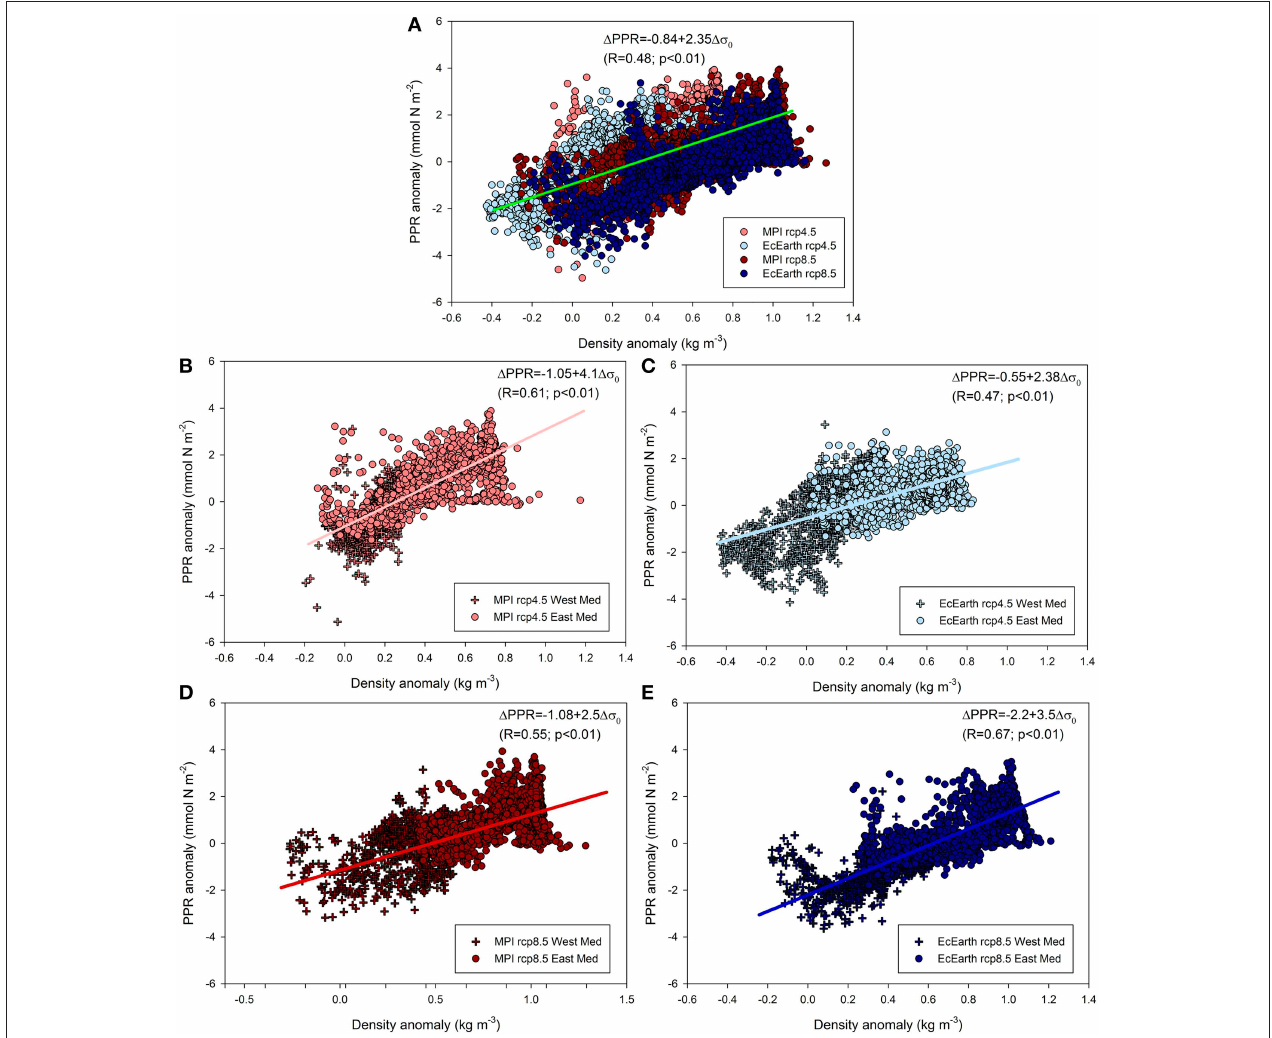
FIGURE 8 | Scatter plot of surface density anomalies vs. PPR anomalies in the different runs. (A) All scenario runs, (B) MPI rcp4.5, (C) EcEarth rcp4.5, (D) MPI rcp8.5, (E) EcEarth rcp8.5.